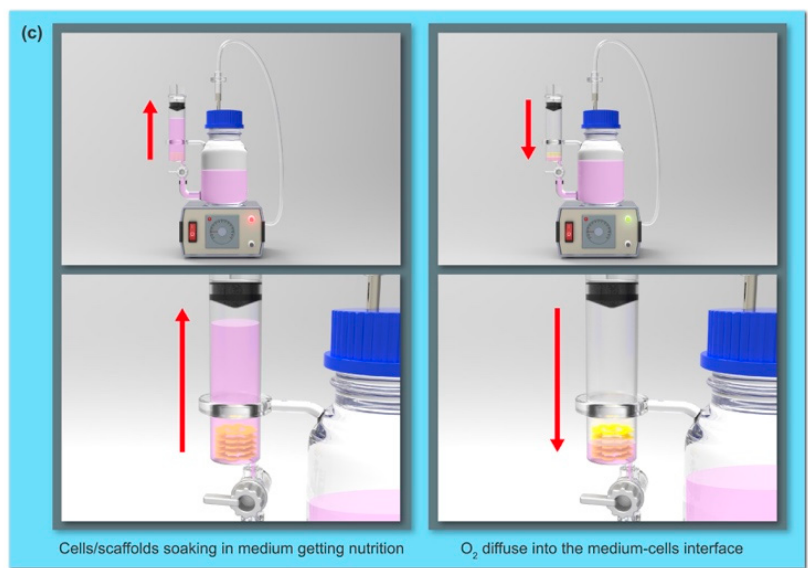
Figure 6. Schematic depiction of hMSCs’ ( a ) expansion in dishes and seeded onto a non-woven fiber disk; ( b ) these hMSCs / disk constructs were subsequently transferred into either a spinner-flask or a bidirectional-flow bioreactor; cells cultured in the non-stirred flask were used as a static culture. The ( c ) shows the medium flow in the culture chamber (left) and medium flow out of the culture chamber (right) in the bidirectional-flow reactor.